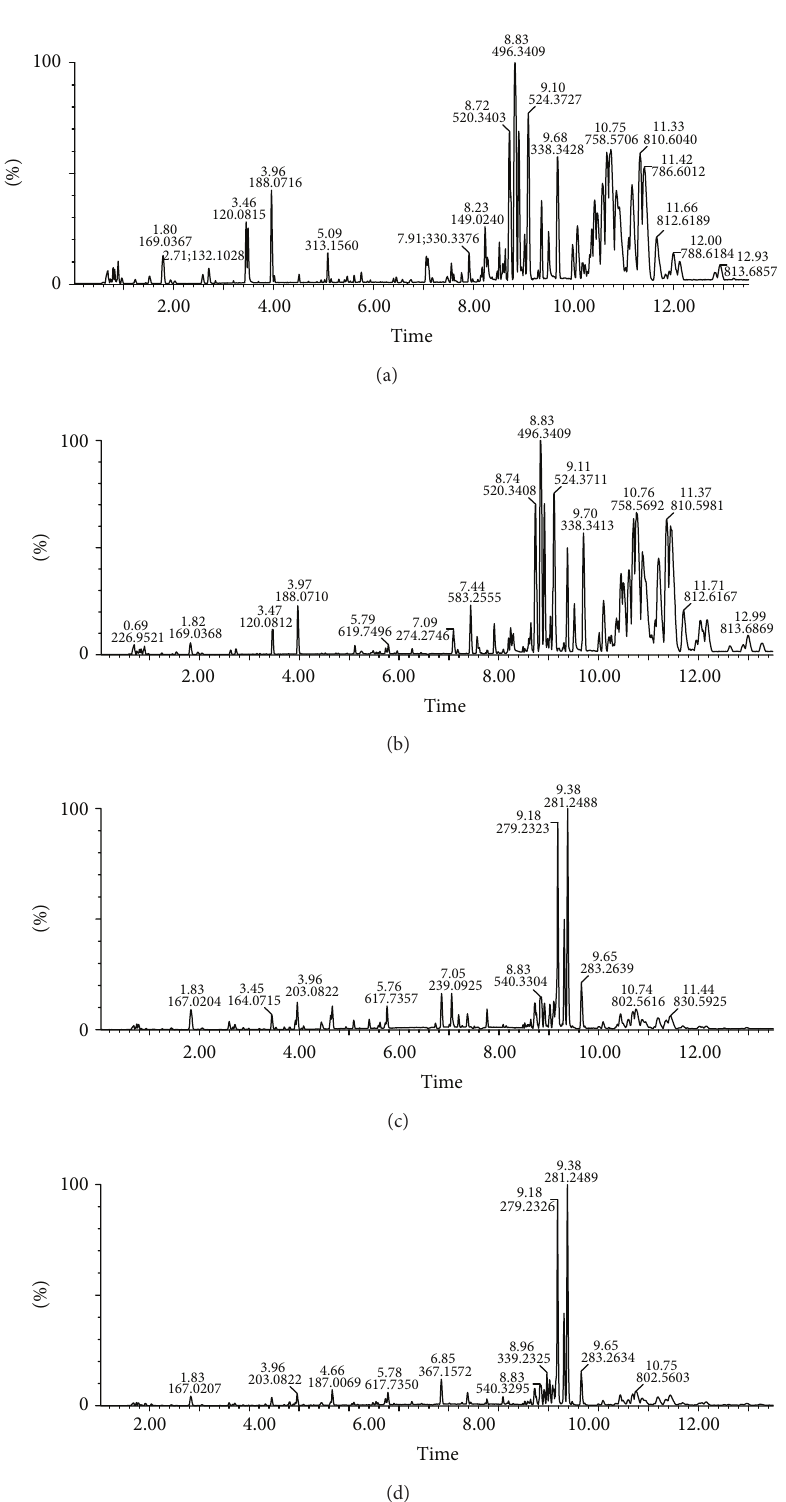
Figure 2: UPLC-Q-TOF/MS BPI chromatograms of human serum samples (a) before SHLI administration in positive ion mode, (b) after SHLI administration in positive ion mode, (c) before SHLI administration in negative ion mode, and (d) after SHLI administration in negative ion